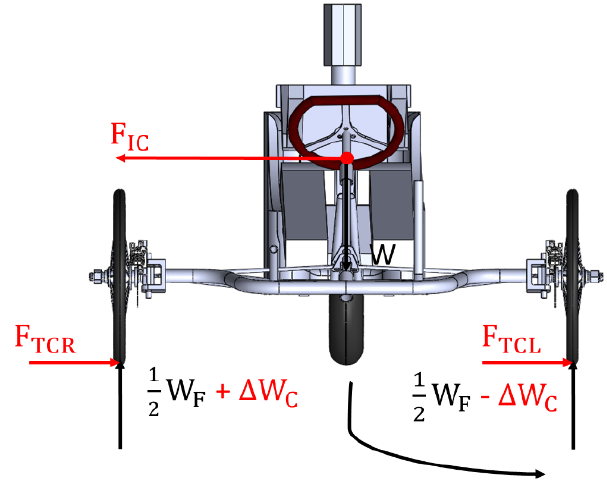
Figure 12. Schematic diagram of the inner and outer wheel loads